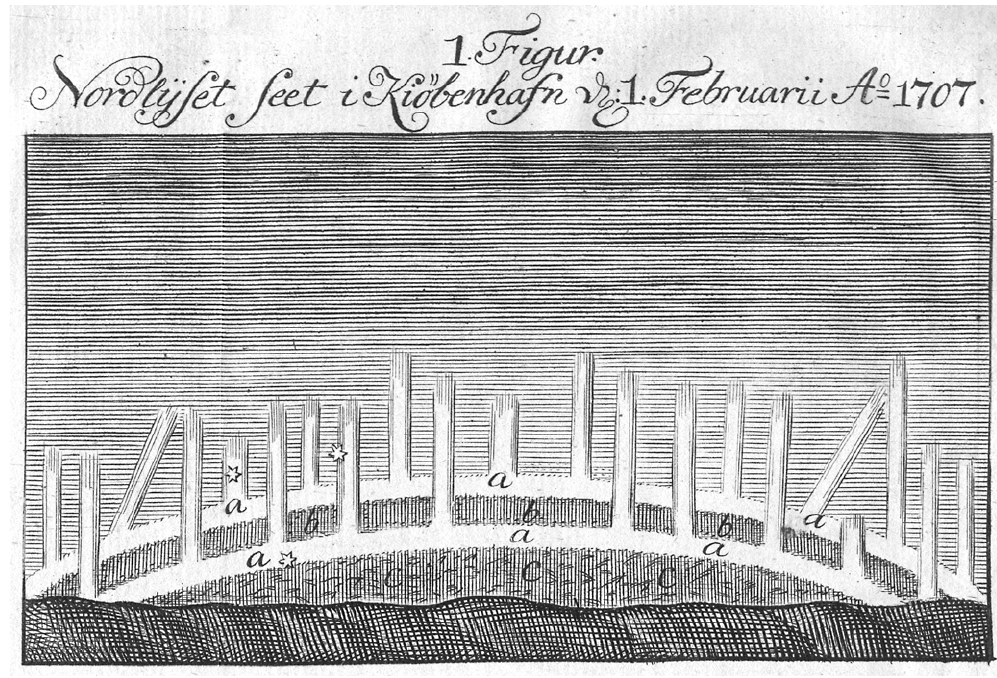
Figure 3. a.a.a: two bright transparent arcs through which the stars are visible; b.b.b: a dark space between the two arcs; c.c.c: a dark space where a dense rain cloud appeared. [ “a.a.a. Zwo helle durchsichtige Bogen, durch welche man die Sterne sehen konnte. b.b.b. Ein dunkler Zwischenraum zwischen den beiden Bogen. c.c.c. Ein dunkler Raum, der einer dichten Regenwolke hnlich war.” ] (Ramus,